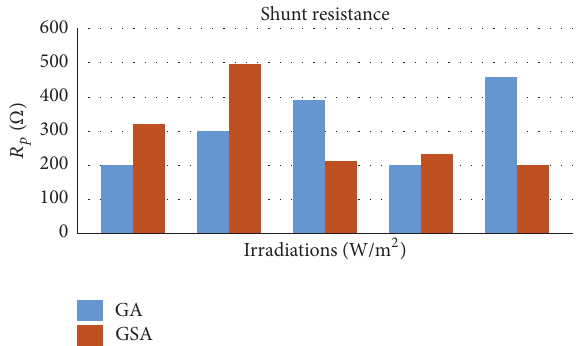
Figure 5: Comparison of the optimized shunt resistance values of Shell S36 under different irradiance conditions.